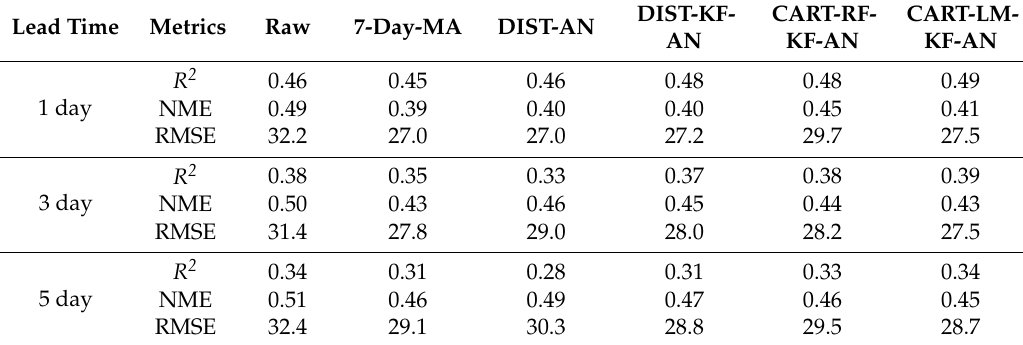
Figure 3. Number counts of the avg-monitors that used each of the 19 features respectively by the linear regression ( a ) and the random forest ( b ) based feature selection method. Performance statistics, R 2 , NME, and RMSE (in ug/m 3 ) after the “local correction estimation”